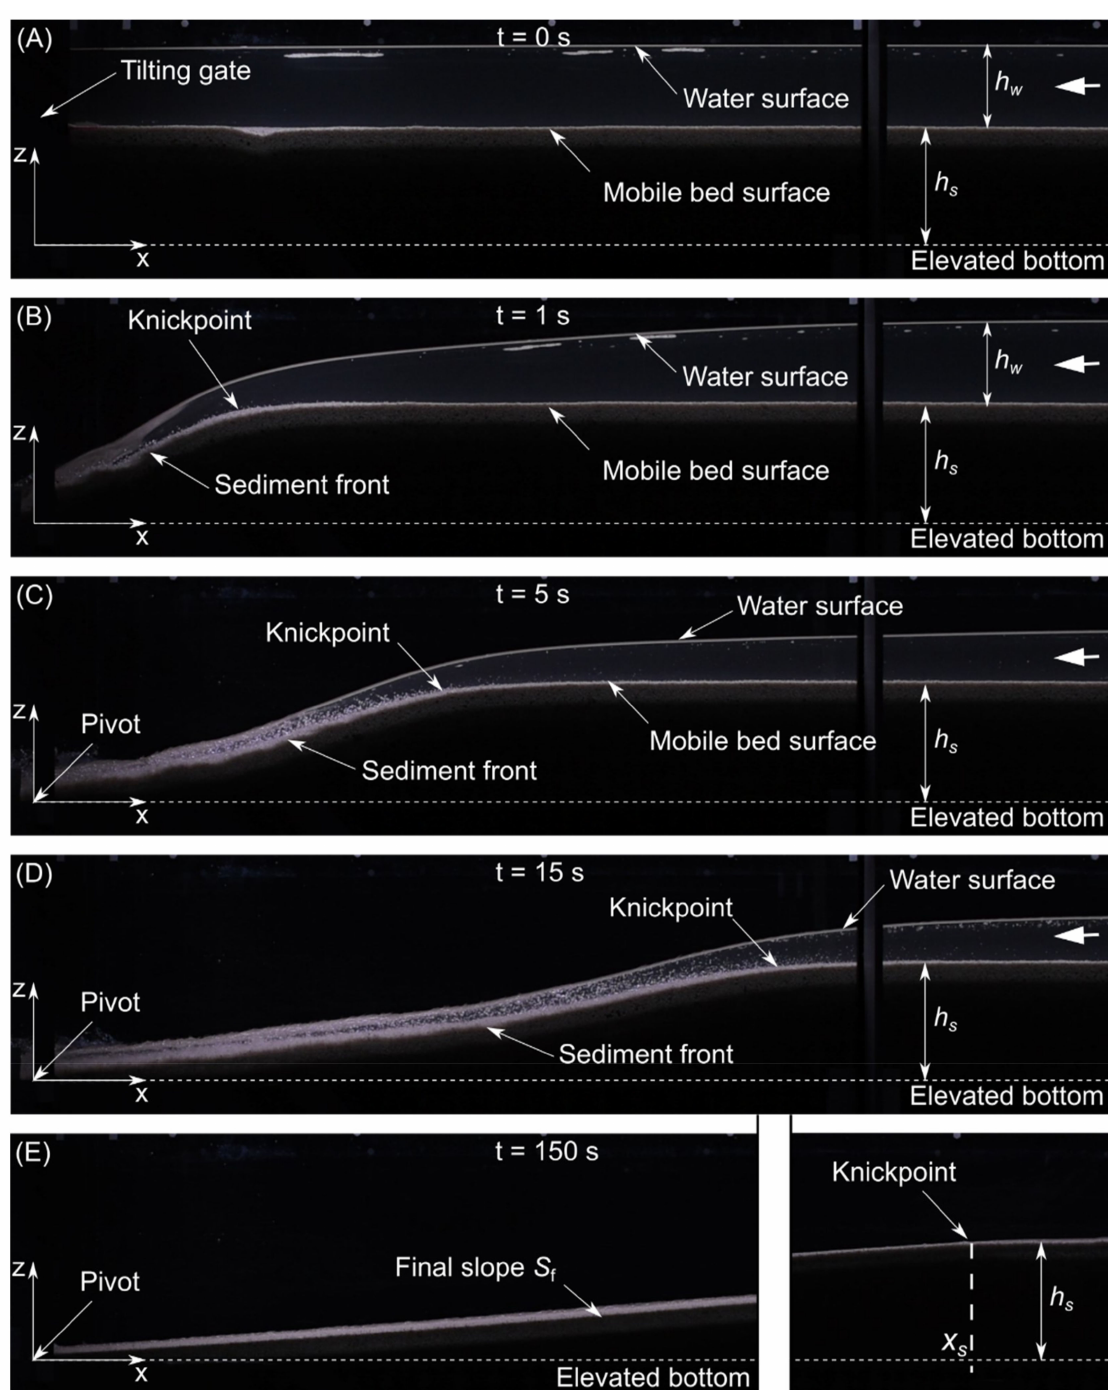
Figure 3. Lateral view of the experiment performed with medium sand, h w · L/h s2 = 26.65, V w /h s 3 = 54.73, and S 0 = 0.0% at the instants: ( A ) t = 0 s, ( B ) t = 1 s, ( C ) t = 5 s, ( D ) t = 15 s, and ( E ) t = 150